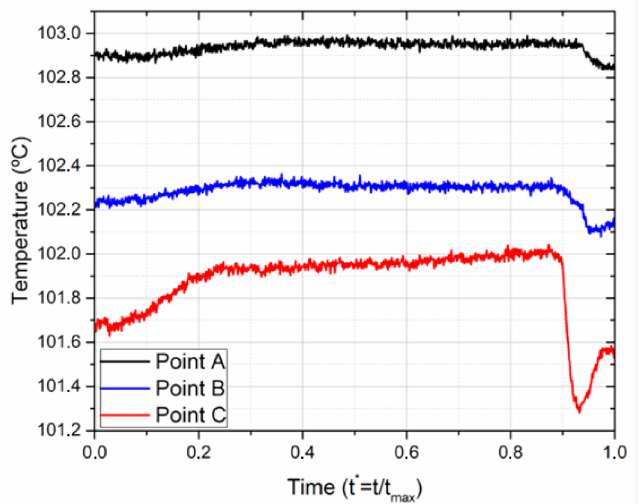
Figure 10. Temperature variation in three points of interest of the biphilic surface. The distance between superhydrophobic regions is δ = 1d, the imposed heat flux is 2132 W/m 2 and the fluid is Ag